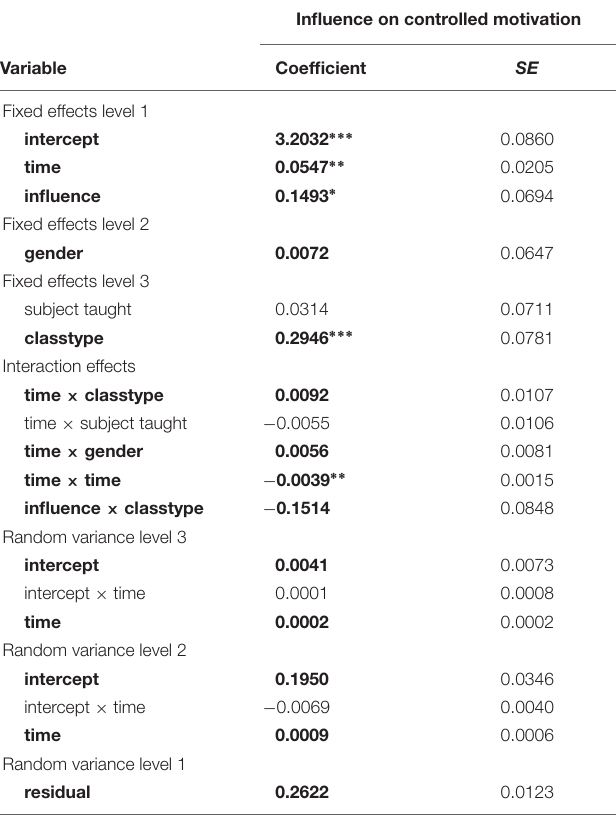
TABLE 5 | ML growth curve results by Maulana et al.